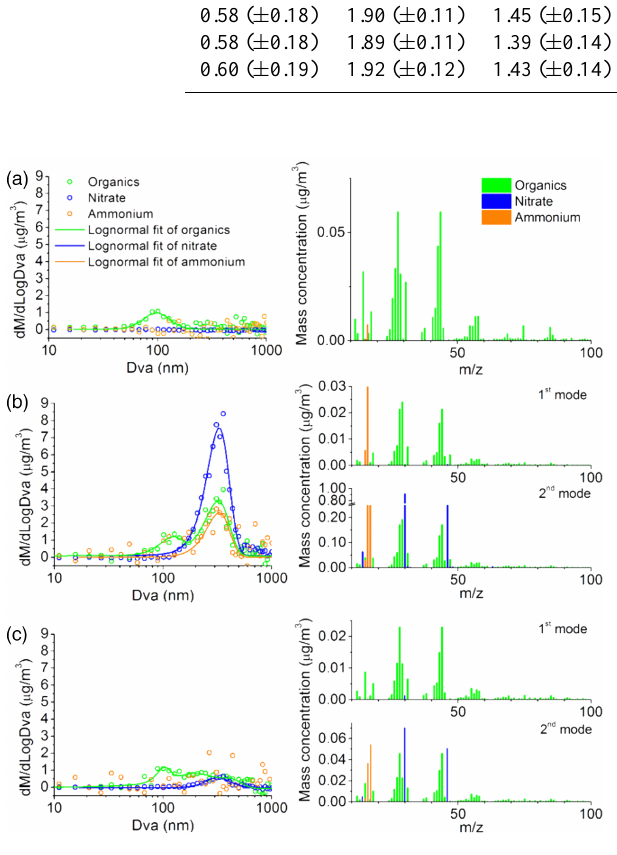
Figure 4. SOA chemical composition measured by an HR-ToF- AMS during a triphasic experiment (T280113) (a) before, (b) dur- ing and (c) 30min after a cloud event. Right panels: mass spectra of dried aerosol averaged over 10min (organic fragments are in green, nitrate fragments in blue and ammonium fragments in orange); Left panels: dried aerosol mass size